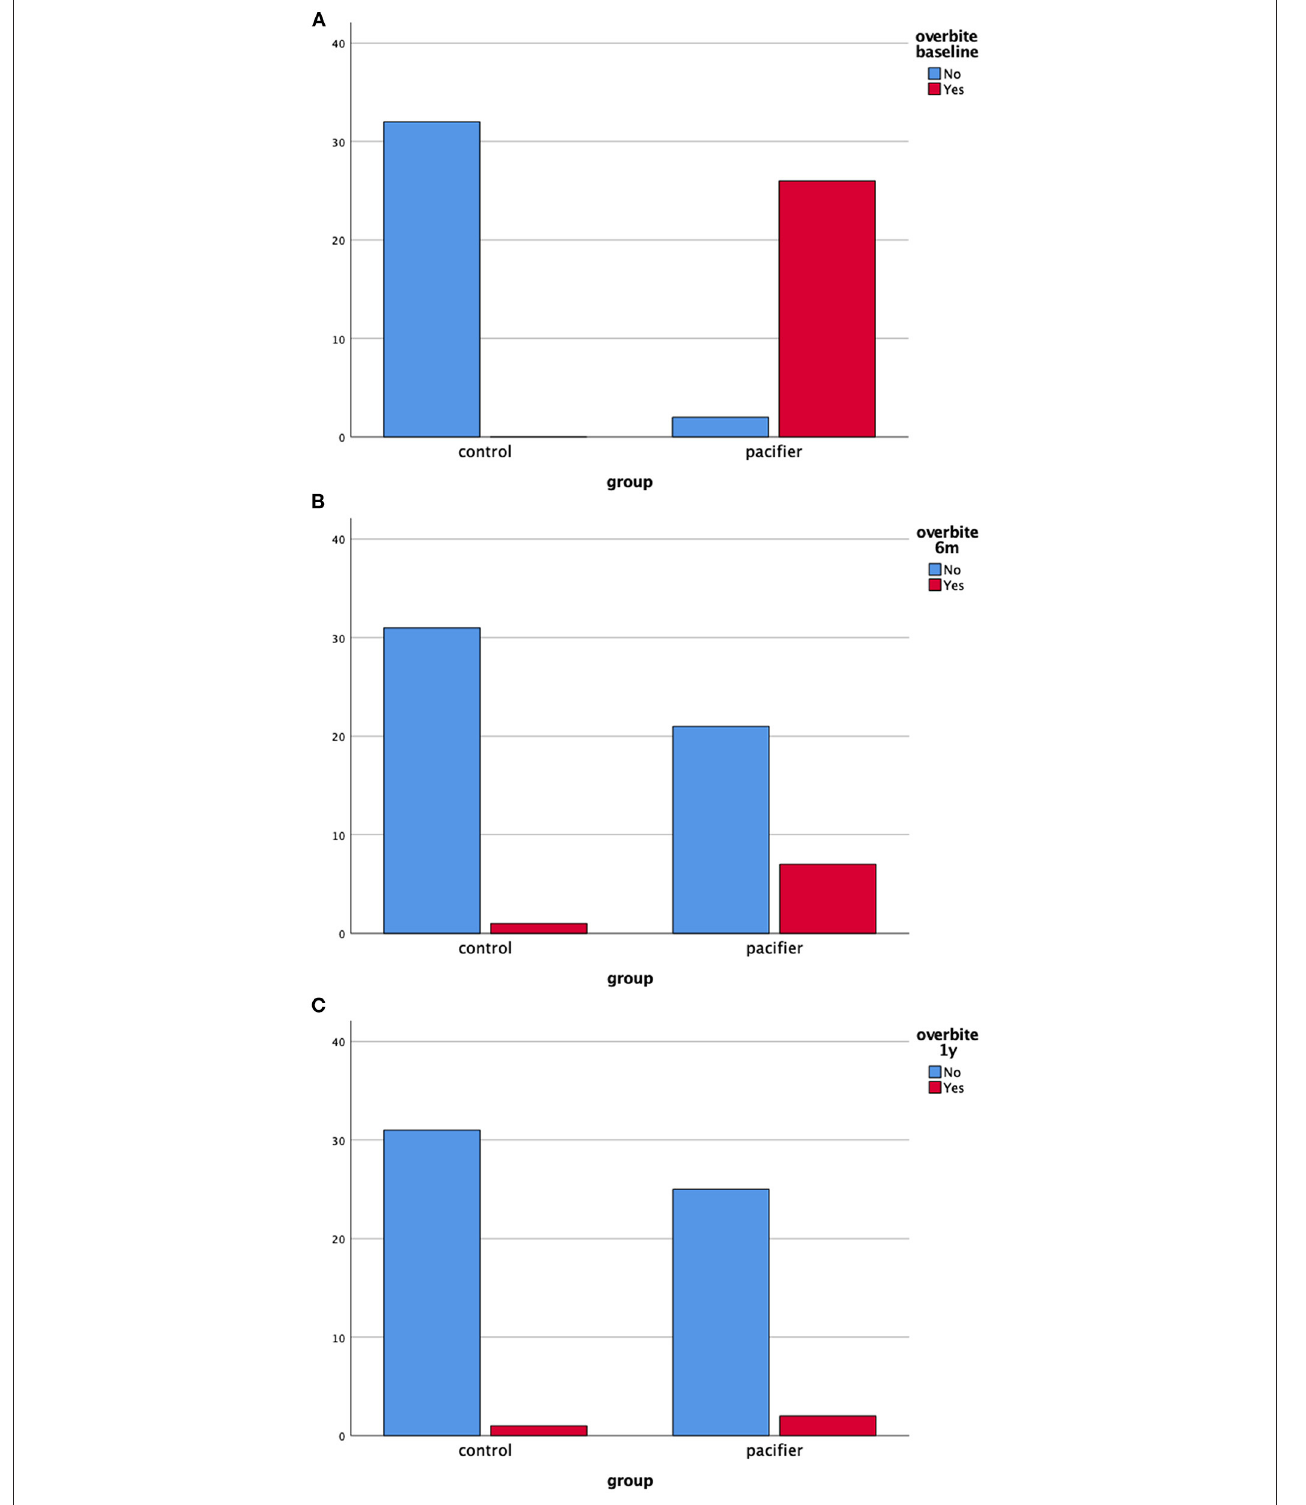
FIGURE 3 | (A–C) Absolute frequency of overbite in the clinical groups at baseline, 6 months and 1-year follow-up (total n = 60).